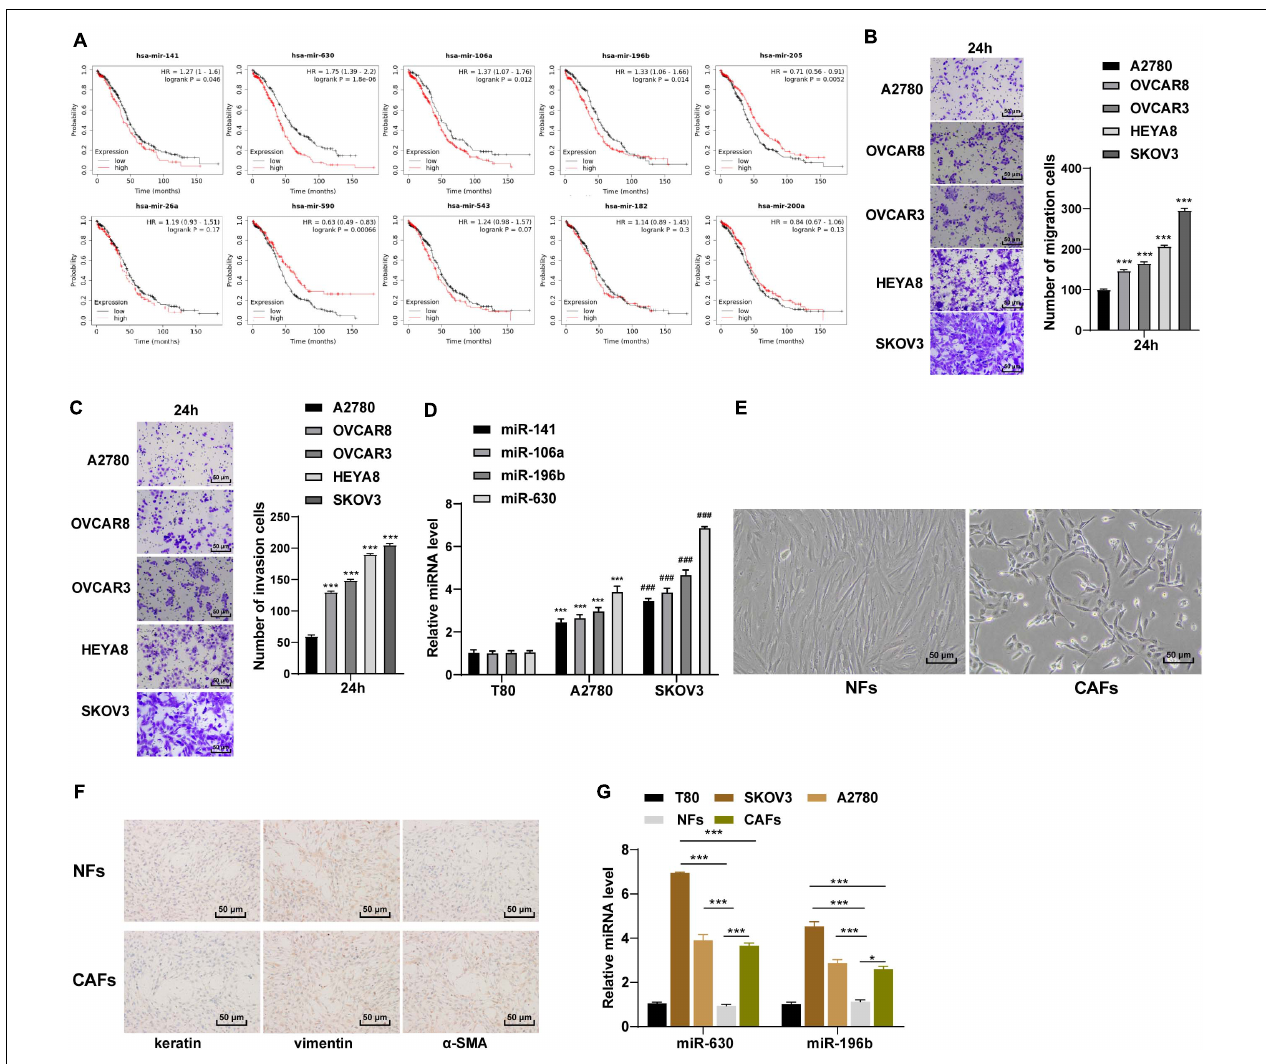
FIGURE 1 | miR-630 was upregulated in OC. (A) Relationship between miRs and prognosis of OC was analyzed by Kaplan–Meier Plotter database; (B,C) OC cells with high metastasis and low metastasis were screened using Transwell assay; (D) Expressions of miR-141, miR-630, miR-106a, and miR-196b in SKOV3 and A2780 cells were detected using RT-qPCR; (E) morphology of NFs and CAFs was observed under the inverted phase contrast microscope; (F) levels of Vimentin, Cytokeratin and α -SMA in NFs and CAFs were detected using immunocytochemistry; (G) expressions of miR-630 and miR-196b in NFs and CAFs were detected using RT-qPCR. The experiment was repeated three times independently. Data are presented as mean ± standard deviation. Data in panels (B,C,D,G) were analyzed using one-way ANOVA, followed by Tukey’s multiple comparison test, *** p < 0.001, ### p <